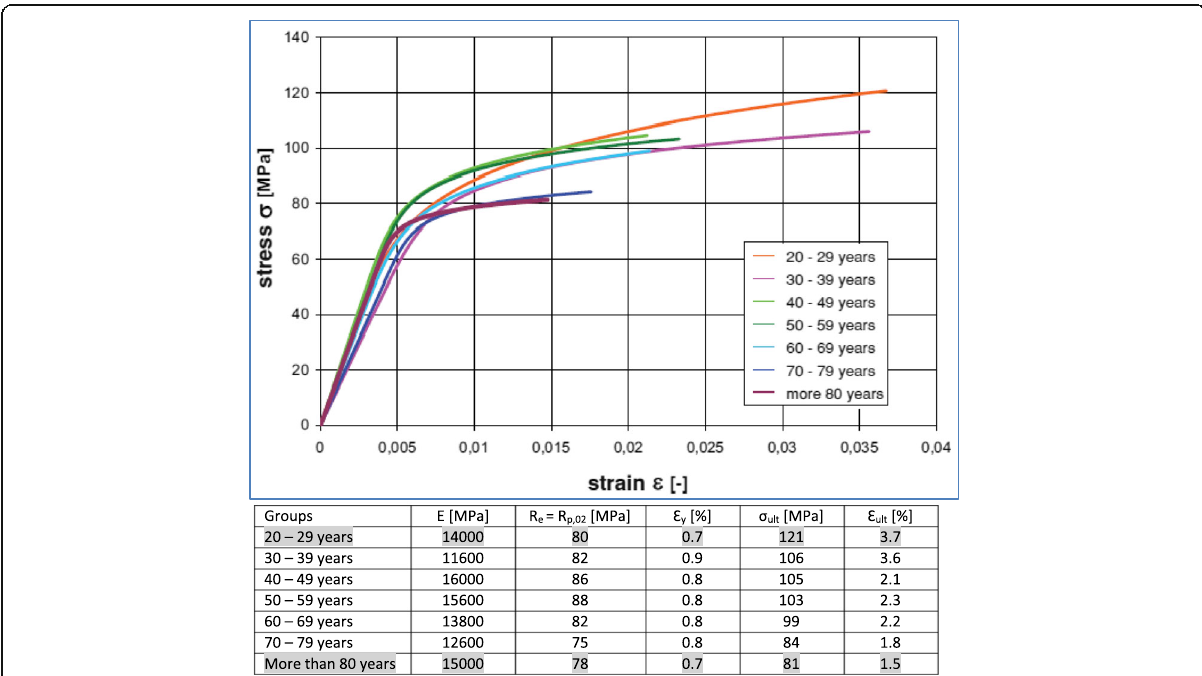
Fig. 6 Age dependent stress – strain curves (Ott 2007; Ott et al. 2010): The values in the table were read from the curves and rounded. A 0.2% offset yield stress ( R p ,0.2 ) has been considered as yield stress ( R e )